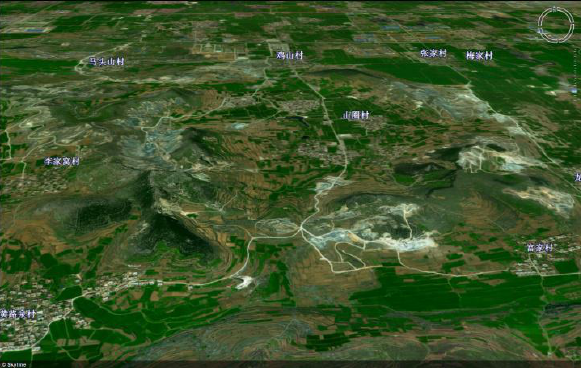
Figure 3. Ring-shaped structure on the 3D image